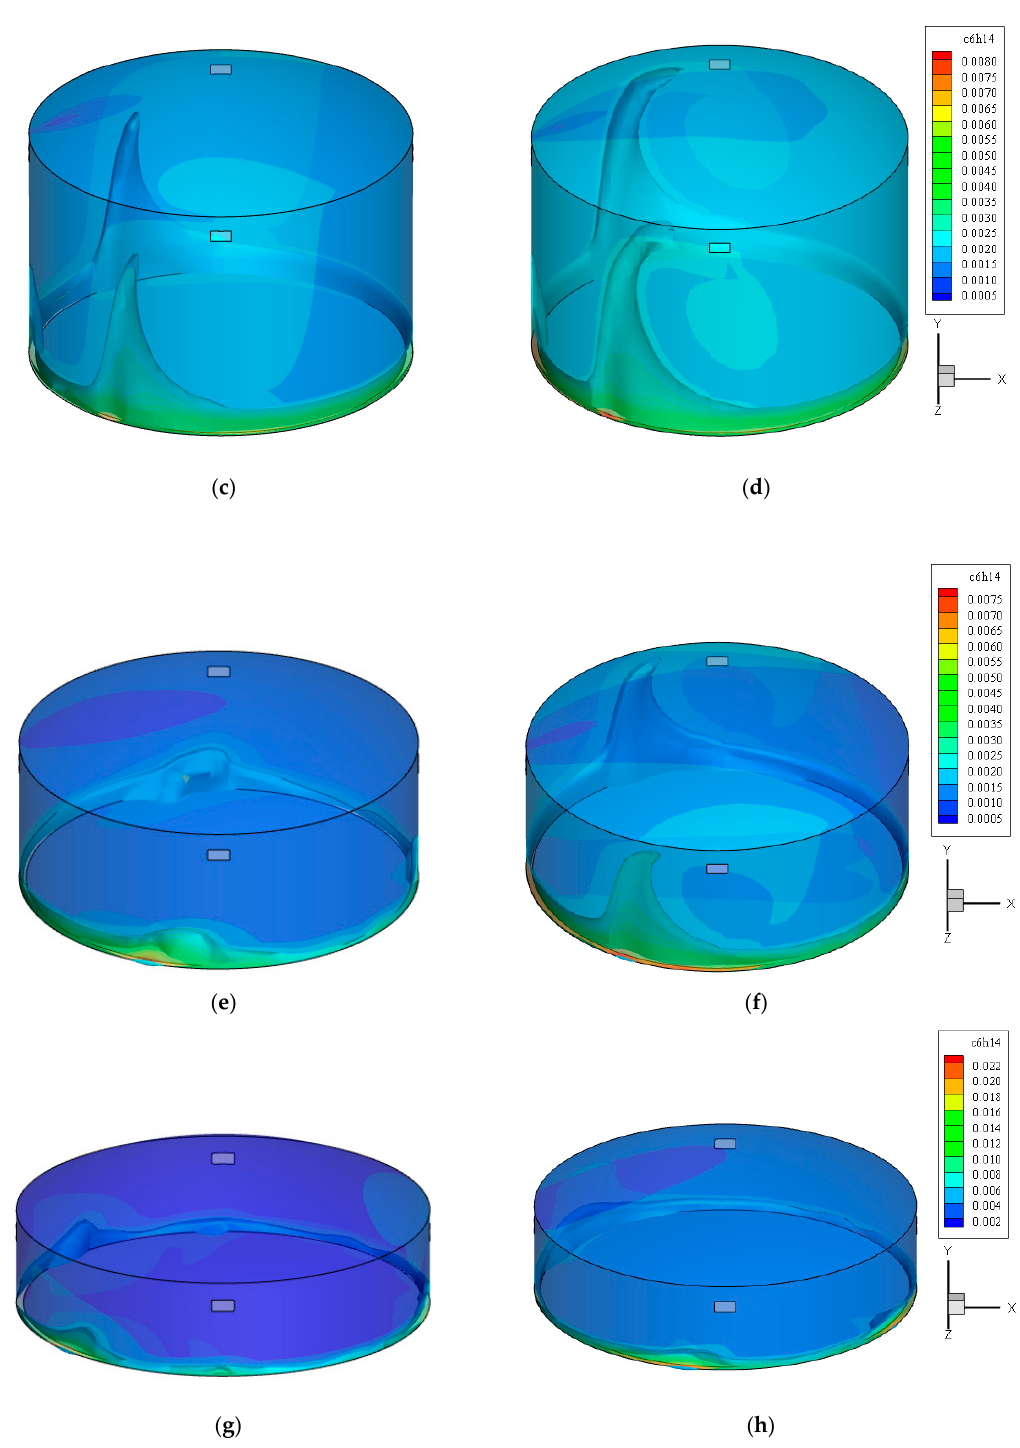
Figure 16. Distribution of n-hexane vapors (mass fraction) in the IFRT at different floating-deck heights. ( a ) Wind speed = 4.36 m·s–1, floating-deck height = 2.82 m. ( b ) Wind speed = 6.36 m·s –1 , floating-deck height = 2.82 m. ( c ) Wind speed = 6.36 m·s –1 , floating-deck height = 5.63 m. ( d ) Wind speed = 4.36 m·s –1 , floating-deck height = 5.63 m. ( e ) Wind speed = 6.36 m·s –1 , floating-deck height = 8.45 m. ( f ) Wind speed = 4.36 m·s –1 , floating-deck height = 8.45 m. ( g ) Wind speed = 6.36 m·s –1 , floating-deck height = 9.98 m. ( h ) Wind speed = 4.36 m·s –1 , floating-deck height = 9.98 m.